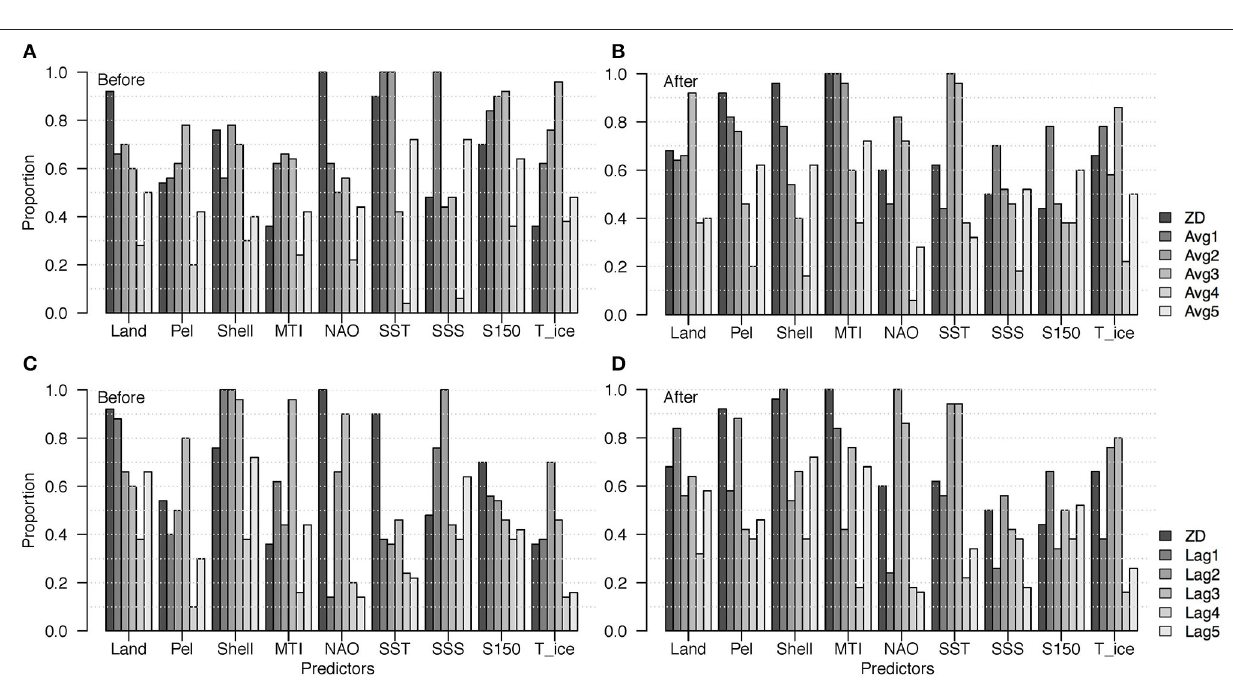
FIGURE 9 | Proportion of times each predictor appeared in the top 50 models of the Before and After models for each delay type and length: (A) Before models, moving average predictors; (B) After models, moving average predictors; (C) Before models, lag predictors; (D) After models, lag